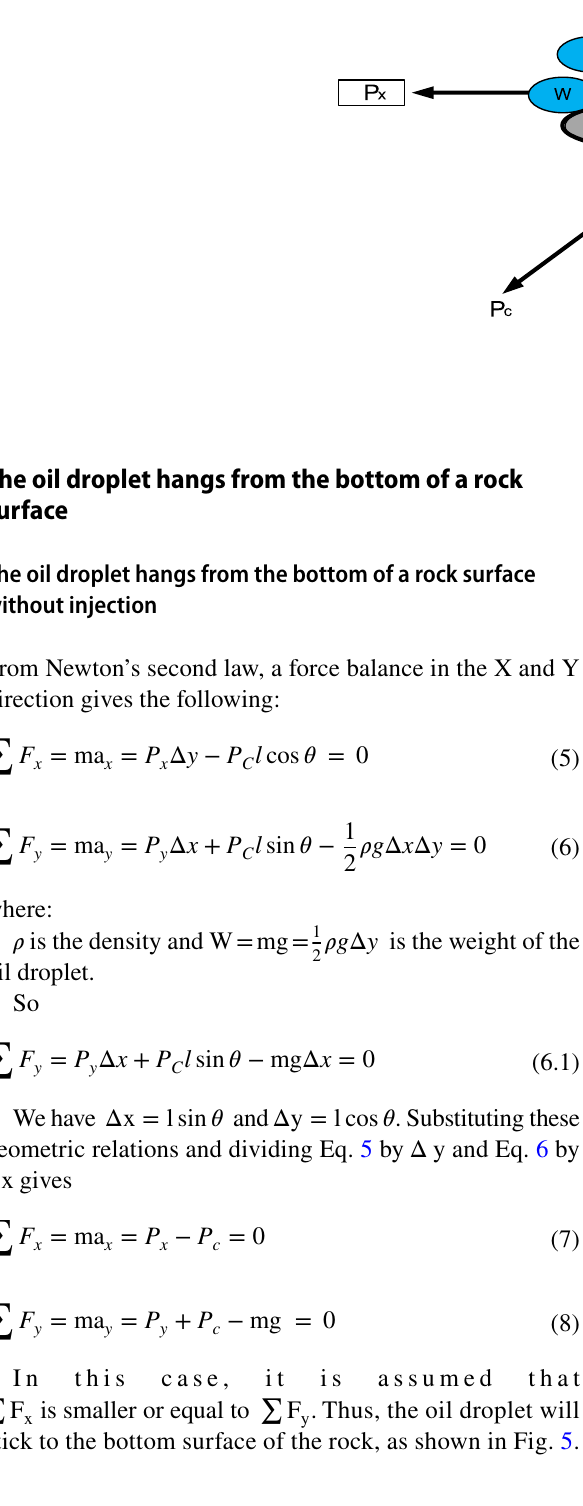
Fig. 4 Forces acting on an oil droplet on the top of a rock surface and its mass